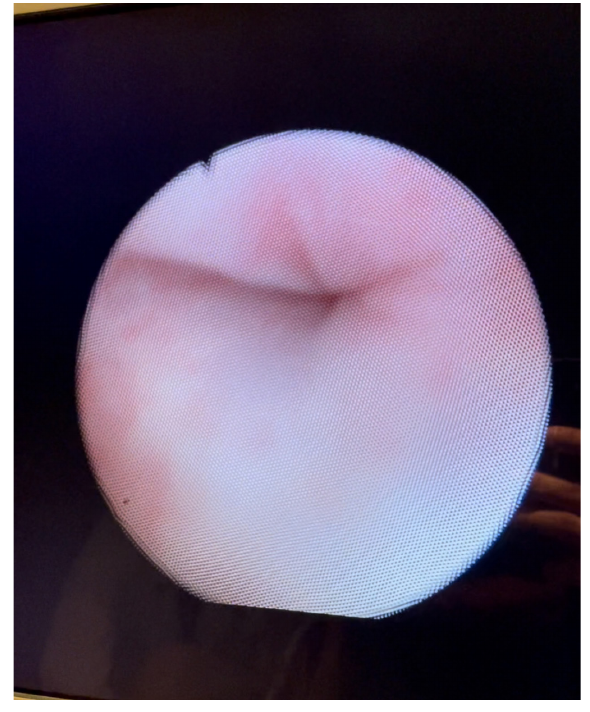
Figure 7. Urethroscopy 6 months after artificial sphincter placement: good sphincter